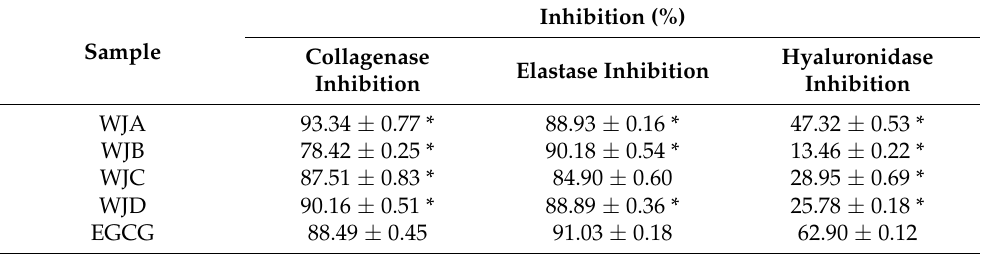
Table 4. Anti-collagenase, anti-elastase, and anti-hyaluronidase activities of the flowers (WJA), roots (WJB), and leaves (annual—WJC and biennial—WJD) of E. japonicum . * Statistically significant differences compared to epigallocatechin gallate (EGCG), p <